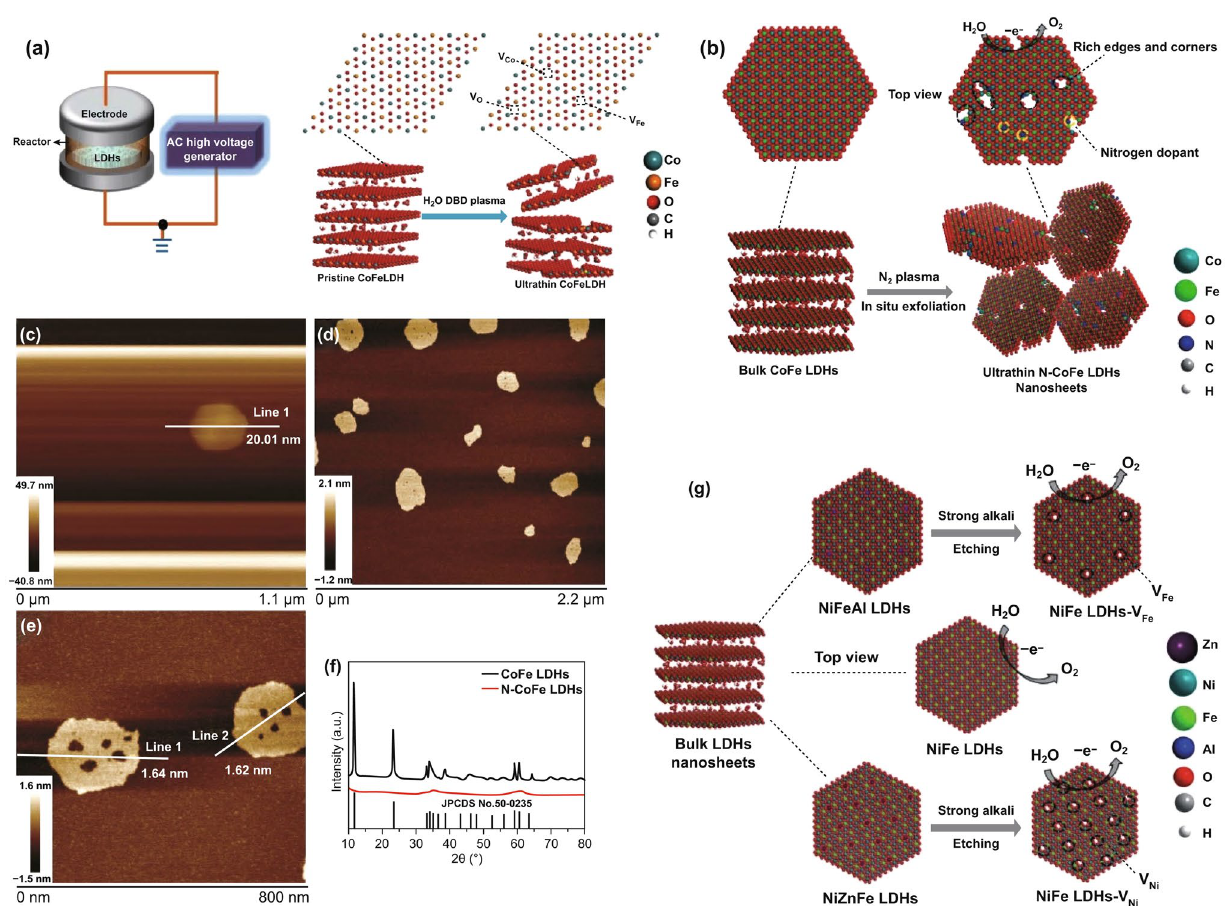
Fig. 6 a Schematic illustration of the water‑plasma‑enabled exfoliation process of CoFe LDH nanosheets. Reproduced with permission of Ref. [75]. Copyright 2017 WILEY–VCH Verlag GmbH & Co. KGaA, Weinheim. b Illustration of the exfoliation process of bulk CoFe LDH into nanosheets by N 2 plasma. c AFM image of the bulk CoFe LDH. d – f AFM images and XRD pattern of the ultrathin N‑CoFe LDH nanosheets. Reproduced with permission of Ref. [76]. Copyright 2018 WILEY–VCH Verlag GmbH& Co. KGaA, Weinheim. g The synthesis of NiFe LDHs‑V Fe and NiFe LDH‑V Ni by strong alkali etching LDHs. Reproduced with permission of Ref. [89]. Copyright 2018 WILEY–VCH Verlag GmbH& Co. KGaA,